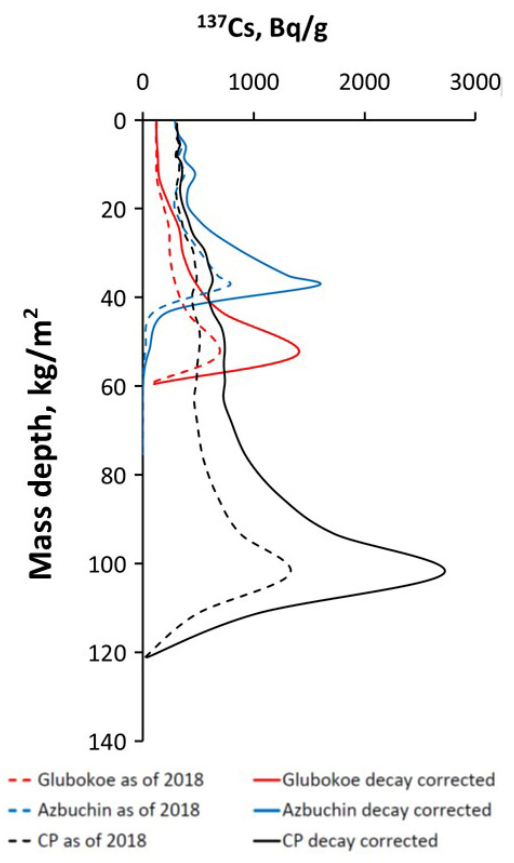
Figure 3. 137 Cs activity concentration profiles corrected for radioactive decay over the time since deposition as a function of mass depth of bottom sediments versus uncorrected profiles, as of the sampling date in 2018.